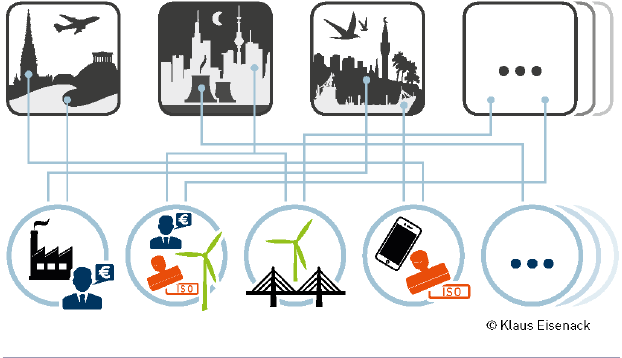
Fig. 1 . Simplified illustration of an archetype analysis of cities (cases represented by boxes, components by bullet points). Each archetype is characterized by a specific configuration of attributes (icons in the circles) from a common vocabulary, supplied with a theory (circle) and a domain of validity (containing all cities to which bulleted arrows from one circle lead). The approach identifies a suite of archetypes instead of a universal model. Like building blocks, archetypes can be combined in different ways to explain the unique character of individual cases (multiple arrows pointing to single